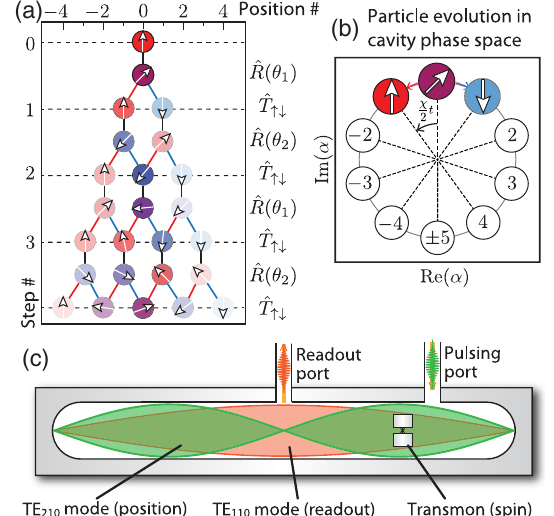
FIG. 1. Quantum-walk implementation in cavity phase space. (a) Schematic representation of a split-step quantum walk on a ˆ R ˆ R line, with rotations ð θ 1 Þ and ð θ 2 Þ and spin-dependent trans- lation T ↑↓ . Red (blue) lines show spin-up (-down) components moving left (right). The opacity of each circle indicates the population on the corresponding lattice site. (b) Set of ten cavity coherent states on which the walk takes place, in the phase space of the TE 210 cavity mode. (c) Cavity resonator and qubit. The fundamental (TE 110 , orange) mode at ω R ¼ 2 π × 6 . 77 GHz is used to measure the qubit state. This mode couples strongly [ κ ¼ 2 π × 600 kHz ¼ 1 = ð 260 ns Þ ] to a 50-ohm transmission line via the readout port at the center of the cavity. The TE 210 cavity mode (green) at ω c ¼ 2 π × 7 . 41 GHz is long lived with an inverse lifetime, κ ¼ 2 π × 4 kHz ¼ 1 = ð 40 μ s Þ . The transmon qubit (coin) has transition frequency ω q ¼ 2 π × 5 . 2 GHz, relax- ation times T 1 ¼ 40 μ s and T (cid:3) 2 ¼ 5 . 19 μ s, and is dispersively coupled to both cavity modes, with the dispersive shift of the walker mode, χ qc ¼ 2 π × 1 . 61